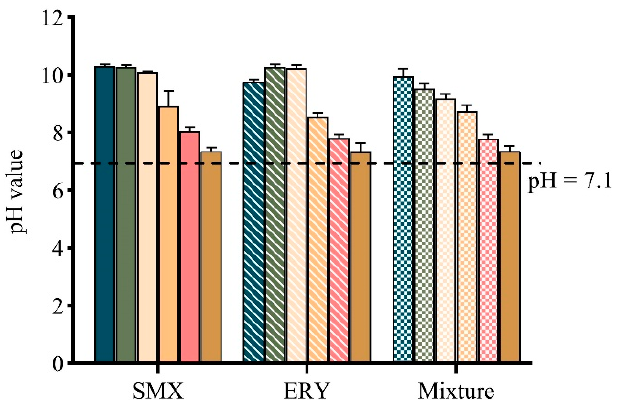
Figure 4. The pH value of R. subcapitata after 11 days exposure to SMX, ERY, and their mixture. SMX (0, 0.1, 0.3, 0.5, 0.7 and 0.9 mg/L), ERY (0, 0.01, 0.03, 0.05, 0.07, and 0.09 mg/L), and their mixture (0, 0.011, 0.033, 0.055, 0.077 and 0.099 mg/L). Data are presented as mean values ± standard deviation (n = 3).